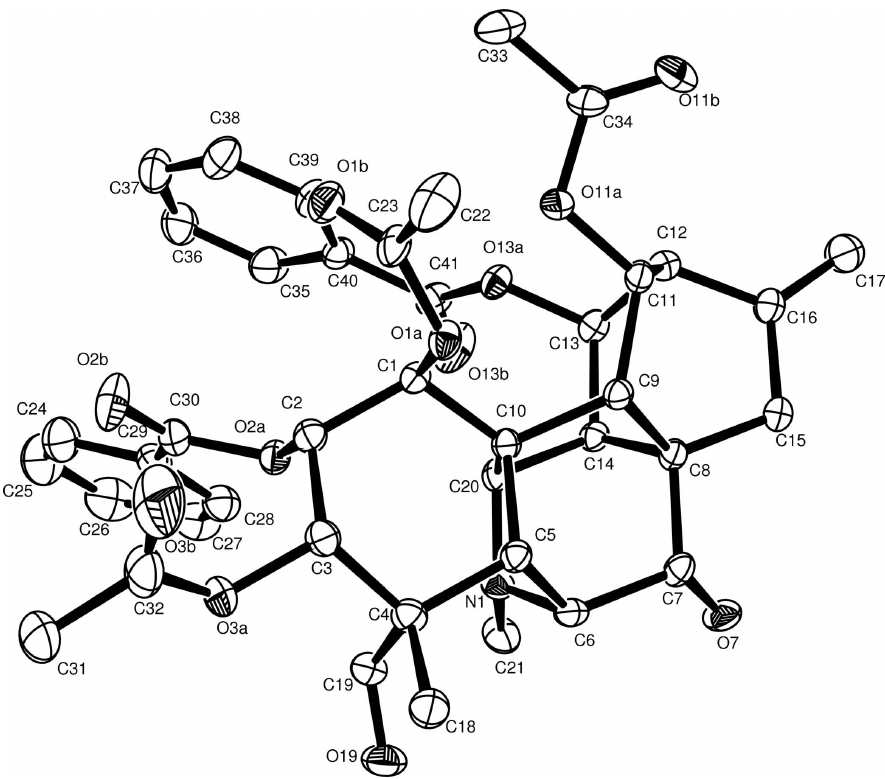
The molecular structure of the title compound with 30% probability displacement ellipsoids for non-H atoms. H atoms have been omitted for